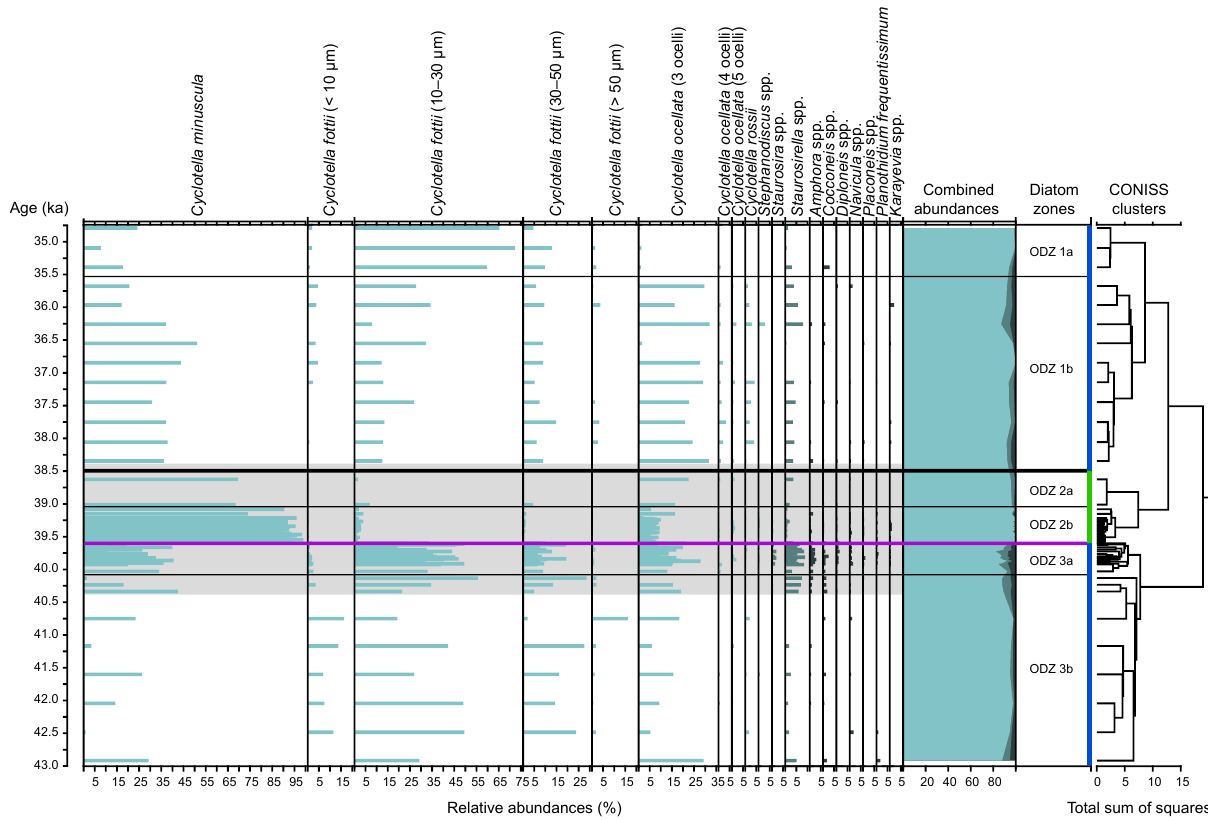
Figure 2. Summary diatom diagram for the Ohrid core (DEEP-5045-1). Only diatom taxa with relative abundances of >2% are shown. Individual abundances are color-coded according to lifestyle (light blueish green: planktonic; medium greyish green: facultative planktonic; dark greyish green: benthic). Diatom zones and subzones were defined by CONISS; zone boundaries are represented with thick solid lines, subzone boundaries with thin solid lines. PAM community clusters are color-coded according to Fig. 4a. The purple line indicates the timing of the Y-5 eruption; the grey-shaded area the duration of the H4 event. Note that the diatom communities had reached the quasi pre-disturbance state (upper blue bar) before the end of the H4